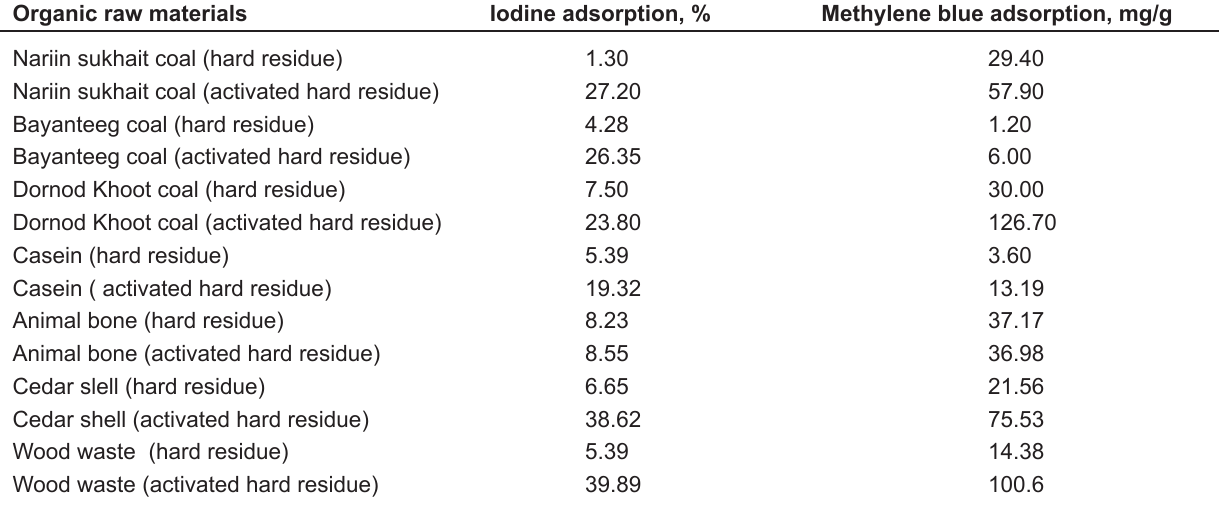
Table 5. Adsorption ability of pyrolysis hard residue and it’s activated carbon of organic raw materials Organic raw